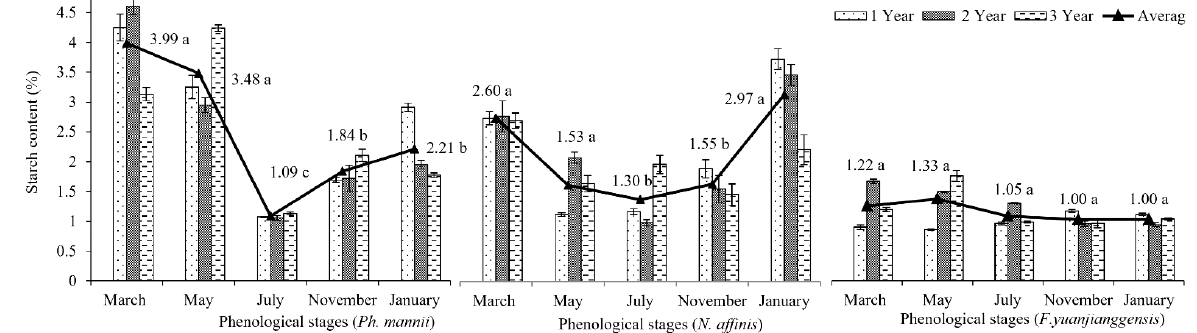
Figure 5. Dynamic changes in the starch contents of three bamboo types at different phenological stages. cal